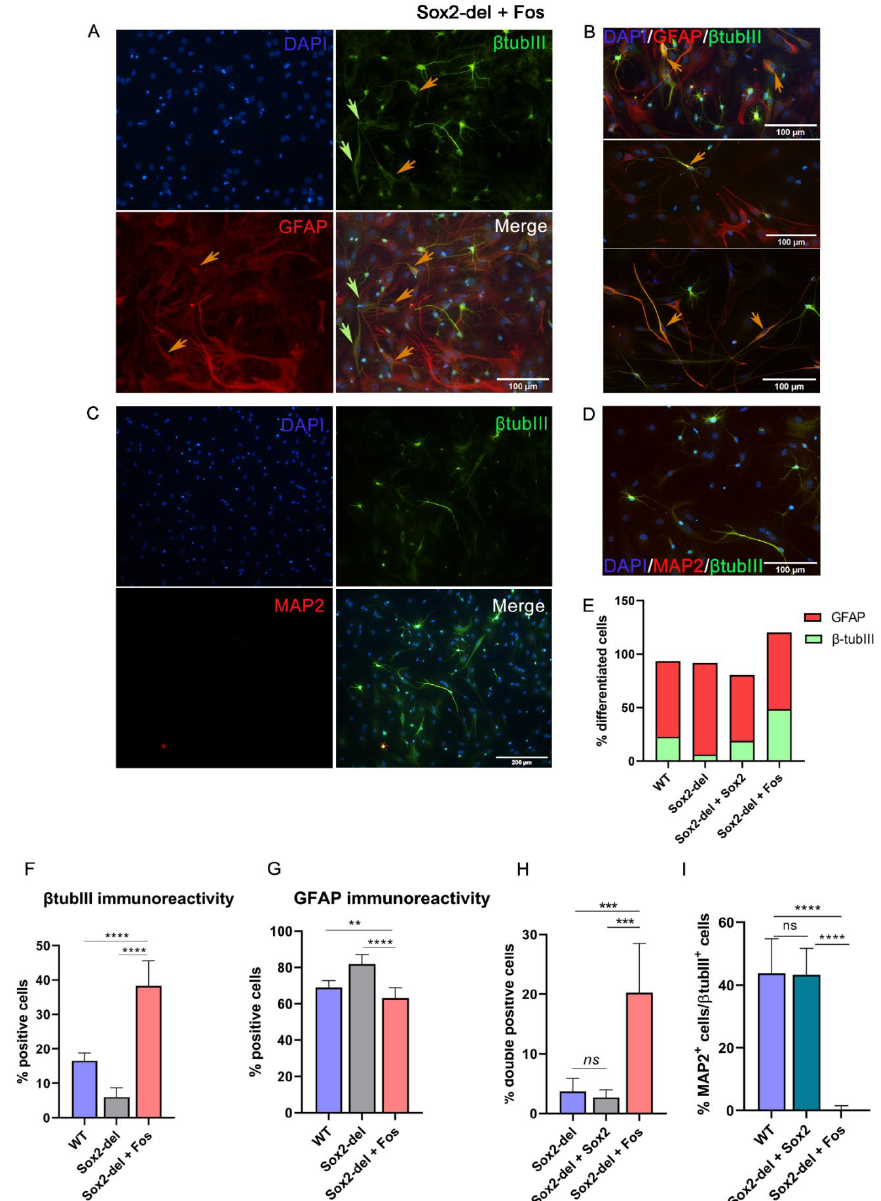
Figure 2. Lentiviral expression of Fos in Sox2 -deleted NSC rescues their ability to generate neurons upon induction of differentiation. IF for β -tubulinIII, GFAP, and MAP2 in Fos -transduced Sox2-del cells (Sox2-del + Fos) at D11. ( A ) Fos overexpression rescues the differentiation into neurons ( β -tubulinIII-positive cells); some cells are positive for both β - tubulinIII and GFAP (orange arrows), and some β -tubulinIII-positive cells have a somewhat “glial” morphology (green arrows). ( B ) Double-positive cells have different morphologies: top panel, glial-like cells; middle panel, neuronal-like cells; bottom panel, poorly defined morphology. ( C , D ) Absence of MAP2 staining in Sox2-del, Fos-transduced differentiated cells. ( E ) Histograms show the percentage of differentiated cells out of the total; in the Sox2-del + Fos population the total % of β -tubIII + GFAP-positive cells is greater than 100%, indicating the existence of double-positive cells. ( F , G ) Percentage of β -tubIII, GFAP, and MAP2-positive cells/total cell number. ( H ) Percentage of double-positive cells/total cell number in Sox2-del, Sox2-del + Sox2, and Sox2-del + Fos samples. Fos overexpressing cells often show double positivity for β -tubIII and GFAP. ( I ) Percentage of MAP2-positive cells/ β -tubIII-positive cells. Results are the mean of 16–20 fields counted in n = 2 independent differentiation experiments. Statistical significance was assessed by Brown Forsythe ANOVA and Dunnet T3 test (**** p < 0.0001; *** p < 0.001; ** p < 0.01; ns: not